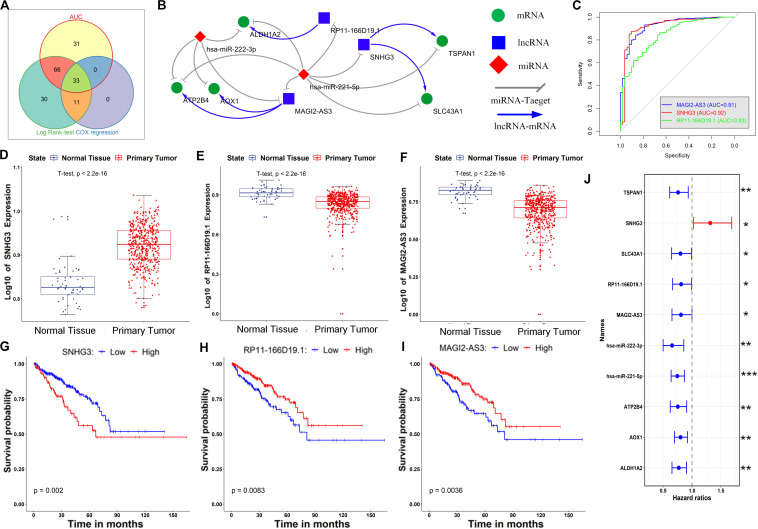
Identification of key RNAs in the ceRNA network and constructing a core ceRNA network. (A) Identification of key RNAs by combining diagnosis and prognosis analyses. (B) The core ceRNA network constructed by mapping the key RNAs to the primary ceRNA network. (C) The AUC of ROC for discriminating the tumor and normal tissues based on the expression of lncRNAs in the core ceRNA network. (D–F) Expression of SNHG3, RP11-166019.1 and MAGI2-AS3 in the normal and tumor tissues of PCa. (G–I) Kaplan–Meier curves of prognostic models built with the expression of SNHG3, RP11-166019.1 and MAGI2-AS3, respectively. (J) Forest plot of hazard ratios showing the prognostic values of all RNAs in the core ceRNA network. *p < 0.05; **p < 0.01; ***p < 0.001.